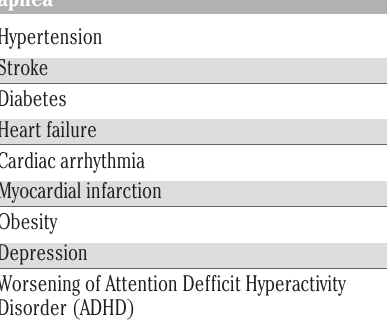
Table 2. Long term health problems associ- ated with untreated obstructive sleep